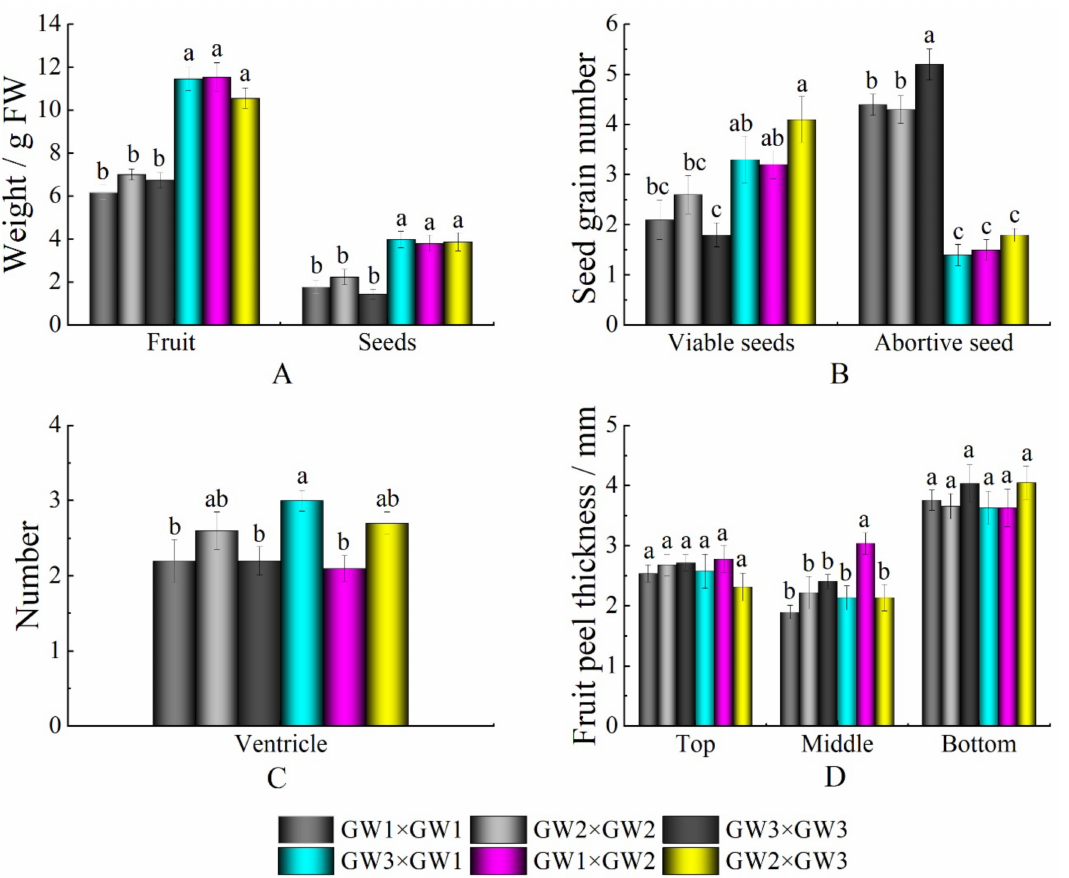
Figure 8. Fruit characteristics under the self- and cross-pollinations. ( A ), fresh fruit and fresh seed weight. ( B ), numbers of fertile and aborted seeds. ( C ), number of ventricles. ( D ), peel thickness. Different letters indicate significant differences between different treatment groups ( p <